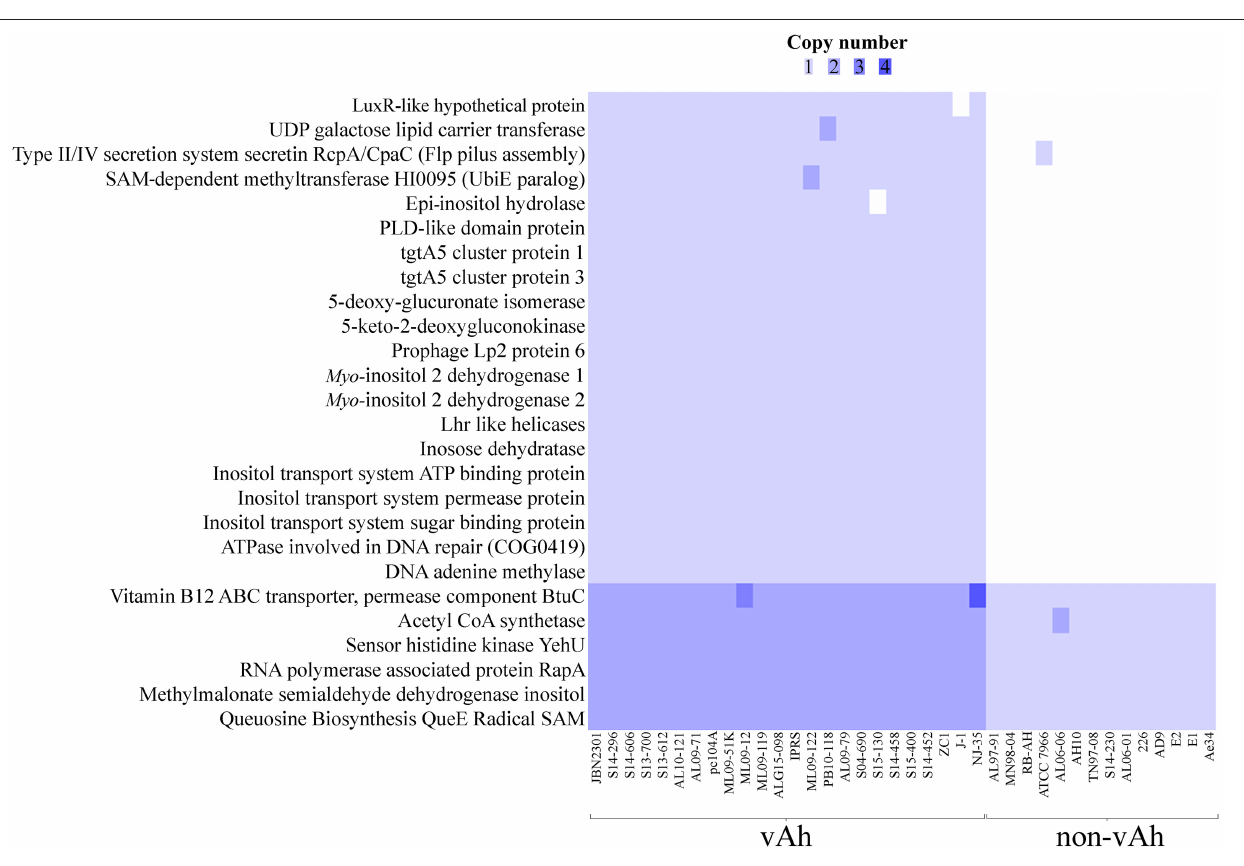
contribution of this secretin to A. hydrophila pathogenesis has yet to be experimentally